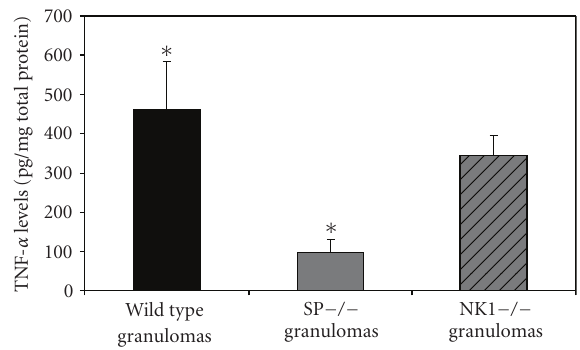
Figure 3: Quantitative levels of TNF- α in granulomas derived from Taenia crassiceps infected, WT ( n = 13), SPP-knockout mice ( n = 4), and NK1-knockout mice ( n = 9). Data presented are mean ± SEM; ∗ P < 05, TNF- α levels in infected, SPP-knockout derived granulomas versus WT derived